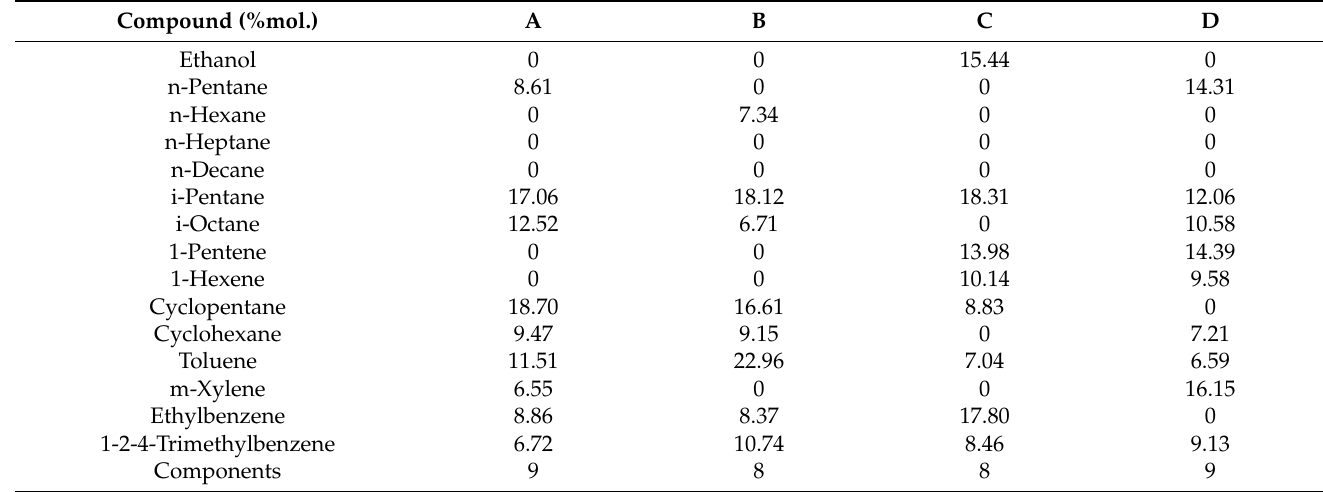
Table A2. Composition of optima surrogates for the four validation